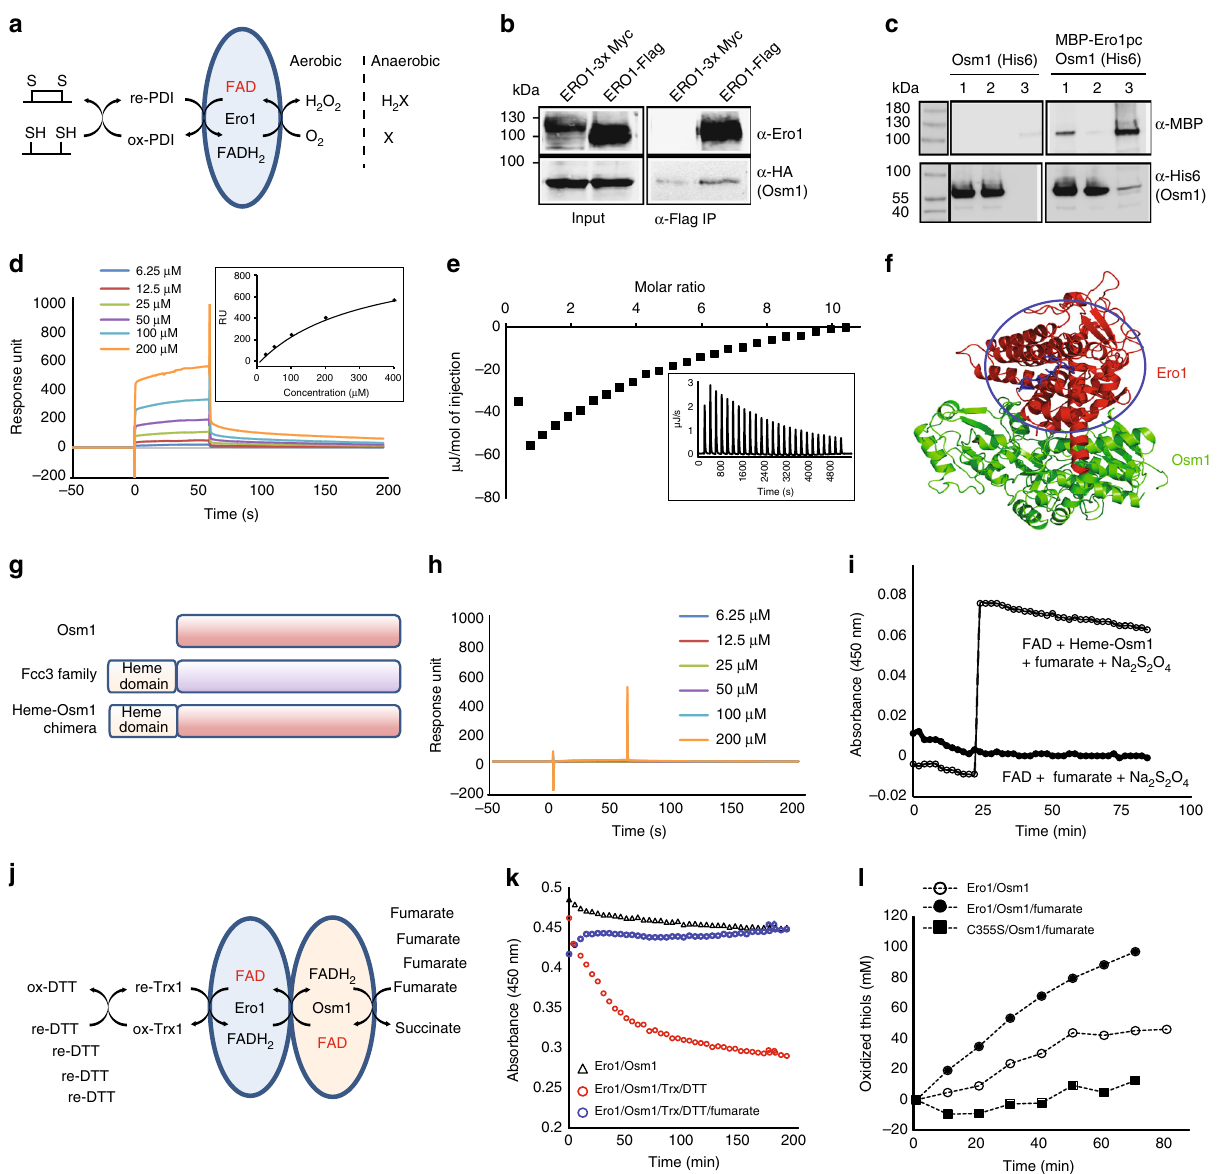
Fig. 4 Physical interaction between Osm1 and Ero1. a Ero1 function. b Co-immunoprecipitation study. Cell lysates from yeast cells co-expressing Ero1- 3×Myc or Ero1-FLAG were immunoprecipitated using anti-FLAG antibody. Samples were separated by SDS-PAGE and immunoblotted using anti-Ero1 antibody or anti-Osm1 serum. c In vitro pull-down assay. The interaction between Osm1 and Ero1 was analyzed by sequential pulldown with nickel then amylose beads. Samples were separated by SDS-PAGE and immunoblotted with anti-MBP and anti-6His antibodies. Lane 1: input; lane 2: fraction not bound to amylose beads; lane 3: 20× fraction bound to amylose beads. d Surface plasmon resonance. Puri fi ed MBP-Ero1 was immobilized and Osm1 was then injected over the surface. All sensorgrams were processed by subtracting the value of a blank sensorgram. Equilibrated response unit plotted against Osm1 concentration is shown in the black box. e The interaction between Osm1 and Ero1 con fi rmed by ITC. Integrated heat area of Ero1 was plotted by Osm1-to-Ero1 molar ratio. f Molecular docking of Osm1 with Ero1. g Domain composition of the Fcc3-Osm1 chimera. h Surface plasmon resonance. The puri fi ed Fcc3-Osm1 chimera was immobilized and Osm1 was then injected. i Reductase activity assay for the Fcc3-Osm1 chimera. Oxidation of FAD by 0.5 µ M Fcc3-Osm1 chimera measured based on absorbance at 450 nm. j Model system used to assess Osm1-Ero1-mediated thiol oxidation. k , l In an airtight environment, when oxygen was depleted by overreaction between Ero1 and a reduced thiol mix (thioredoxin/DTT), the Ero1- and Osm1-bound FAD was reduced. However, fumarate inhibited this FAD reduction by working as an electron acceptor ( k ). At the same time, oxidized thiol molecules in reaction increased ( l ). The catalytically inactive Ero1 mutant, C355S, could not oxidize thiols even in the presence of Osm1 and